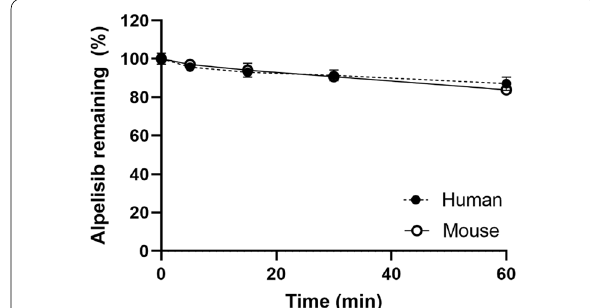
Fig. 3 Residual levels of alpelisib (%) after incubation with β‑nicotinamide adenine dinucleotide phosphate in human (closed circles) and mouse liver microsomes (open circles). Each data point represents the mean SD ( n 3 for each group) Fig. 4 Plasma concentration–time curve (semilogarithmic scale) ± =